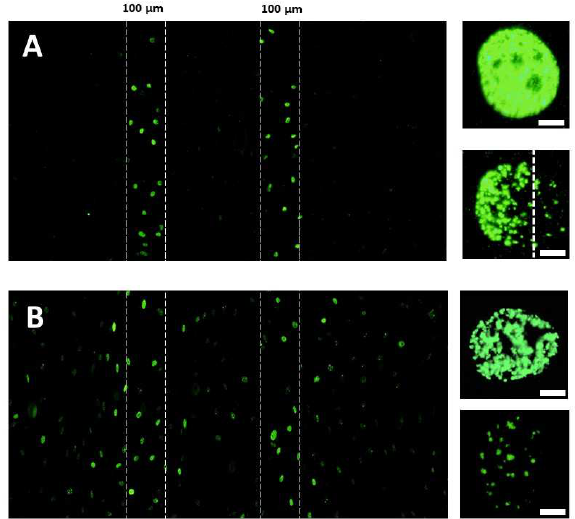
Figure 2. Characterization of the RIBE induced by a micro-irradiation approach with 50 keV syn- chrotron X-rays. Anti- γH2AX immunofluorescence was applied to the radioresistant 1BR3 fibroblasts irradiated at 10 Gy. Two 100-µm-wide parallel 50 keV synchrotron X-rays micro-tracks separated by 300 µm were generated (delimited by white dashed lines). Cells were fixed 10 min ( A ) or 4 h ( B ) post-irradiation and γH2AX immunofluorescence was applied (10× magnification). Inserts. Representative examples of γH2AX-positive nuclei situated either inside or at the edge of the micro- tracks (10 min post-irradiation) ( A ) or either inside or 200 µm far from the micro-tracks ( B ) (100× magnification). The white bars represent 5 µm. The number of γH2AX foci per cell decreased as a function of the distance from the micro-tracks. The mathematical function that links the number of γH2AX foci and the distance from the micro-tracks was also found dependent on the post-irradiation time (Figure 3). Particularly, the γH2AX foci observed in RIBE cells appeared early (10 min) after irradiation. In our conditions, the maximal number of γH2AX foci was reached at 1 h post-irradiation. The larger distance from the micro-tracks at which some γH2AX foci were still observed was reached at 4 h post-irradiation (Figure 3A,B). Similar observations were made with the other doses tested (data not shown for 1 and 5 Gy).